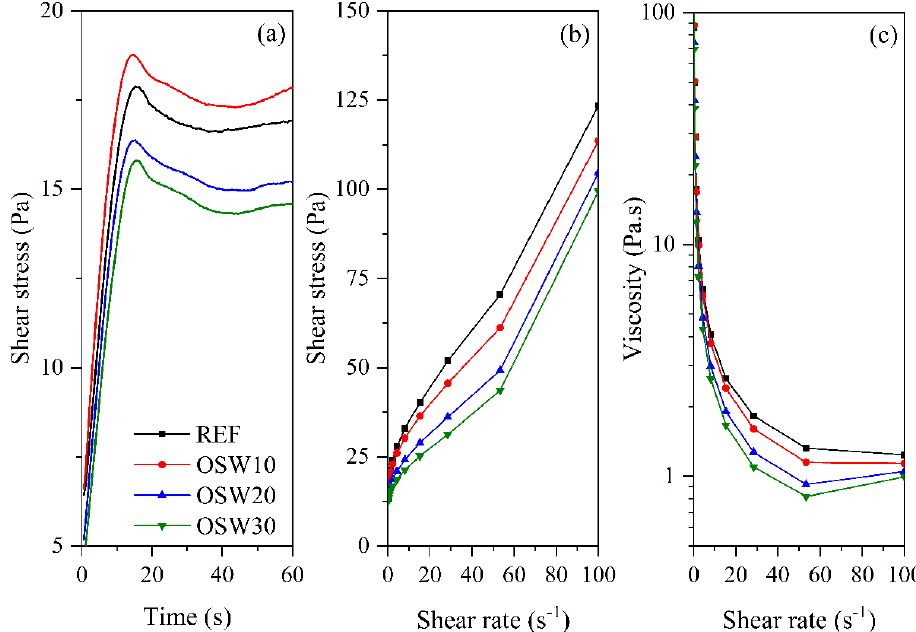
Figure 6. Curves of rheological tests. ( a ) static yield stress determination ( b ) flow curves, and ( c ) viscosity vs. shear rate curves of cement pastes.